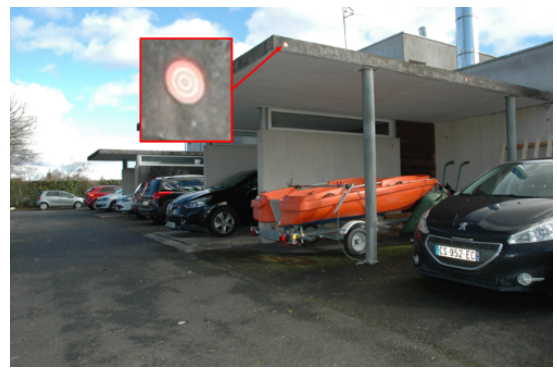
Figure 6. House set